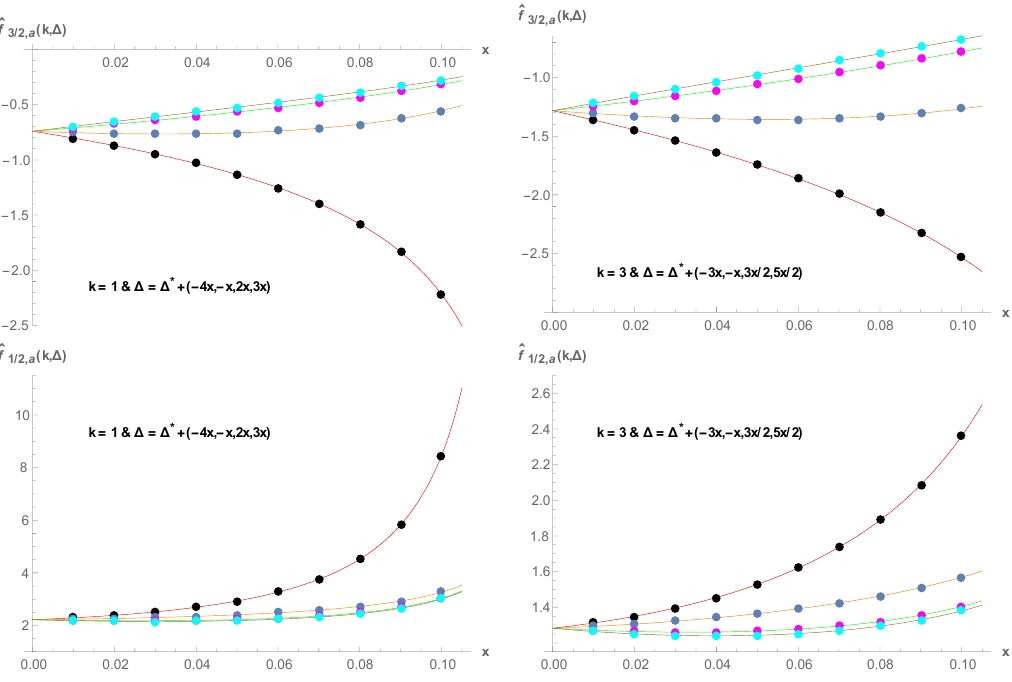
ˆ ( k, ∆) in f (lmf) X,a ( k, ∆) on X,a